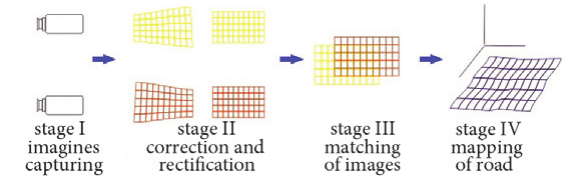
Fig. 1. The stages of stereo vision